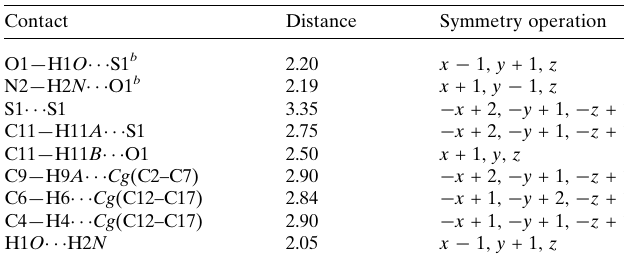
Table 2 A summary of short interatomic contacts (A˚ ) for (I) a . Contact